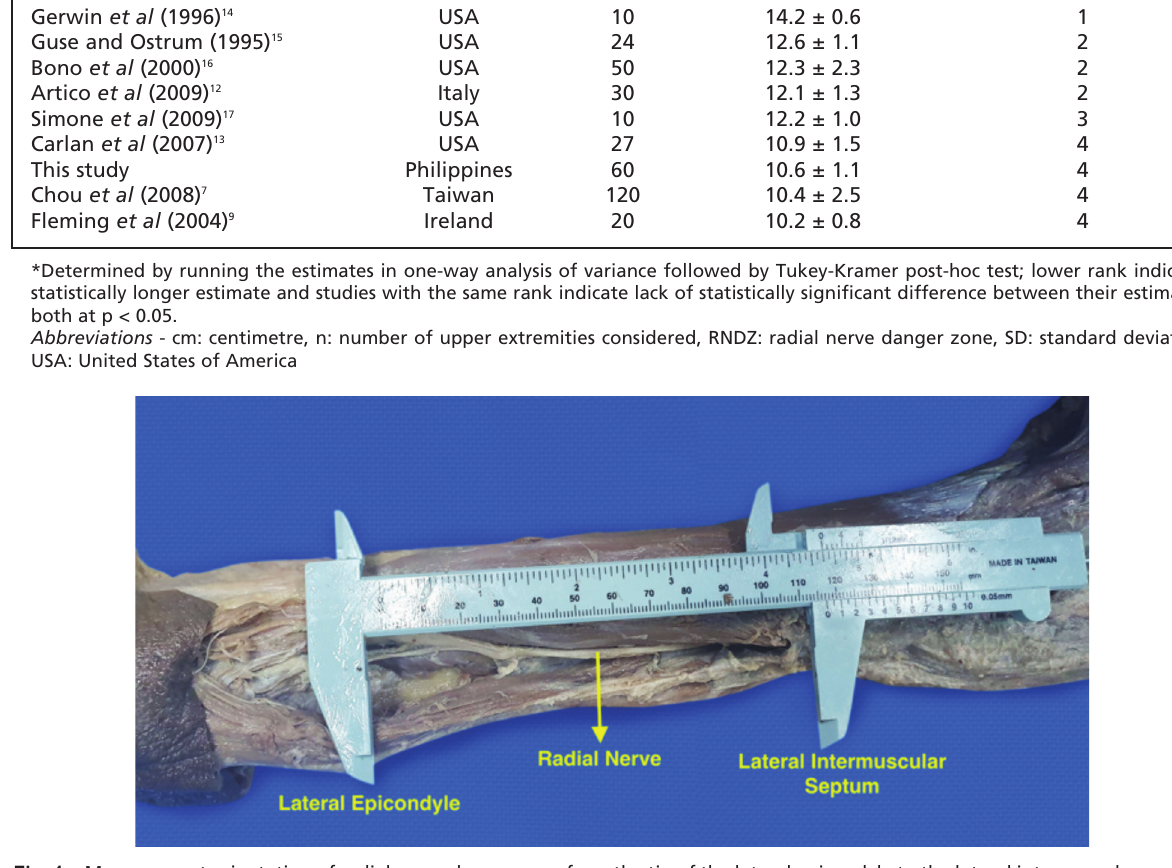
Measurement orientation of radial nerve danger zone from the tip of the lateral epicondyle to the lateral intermuscular Fig. 1: